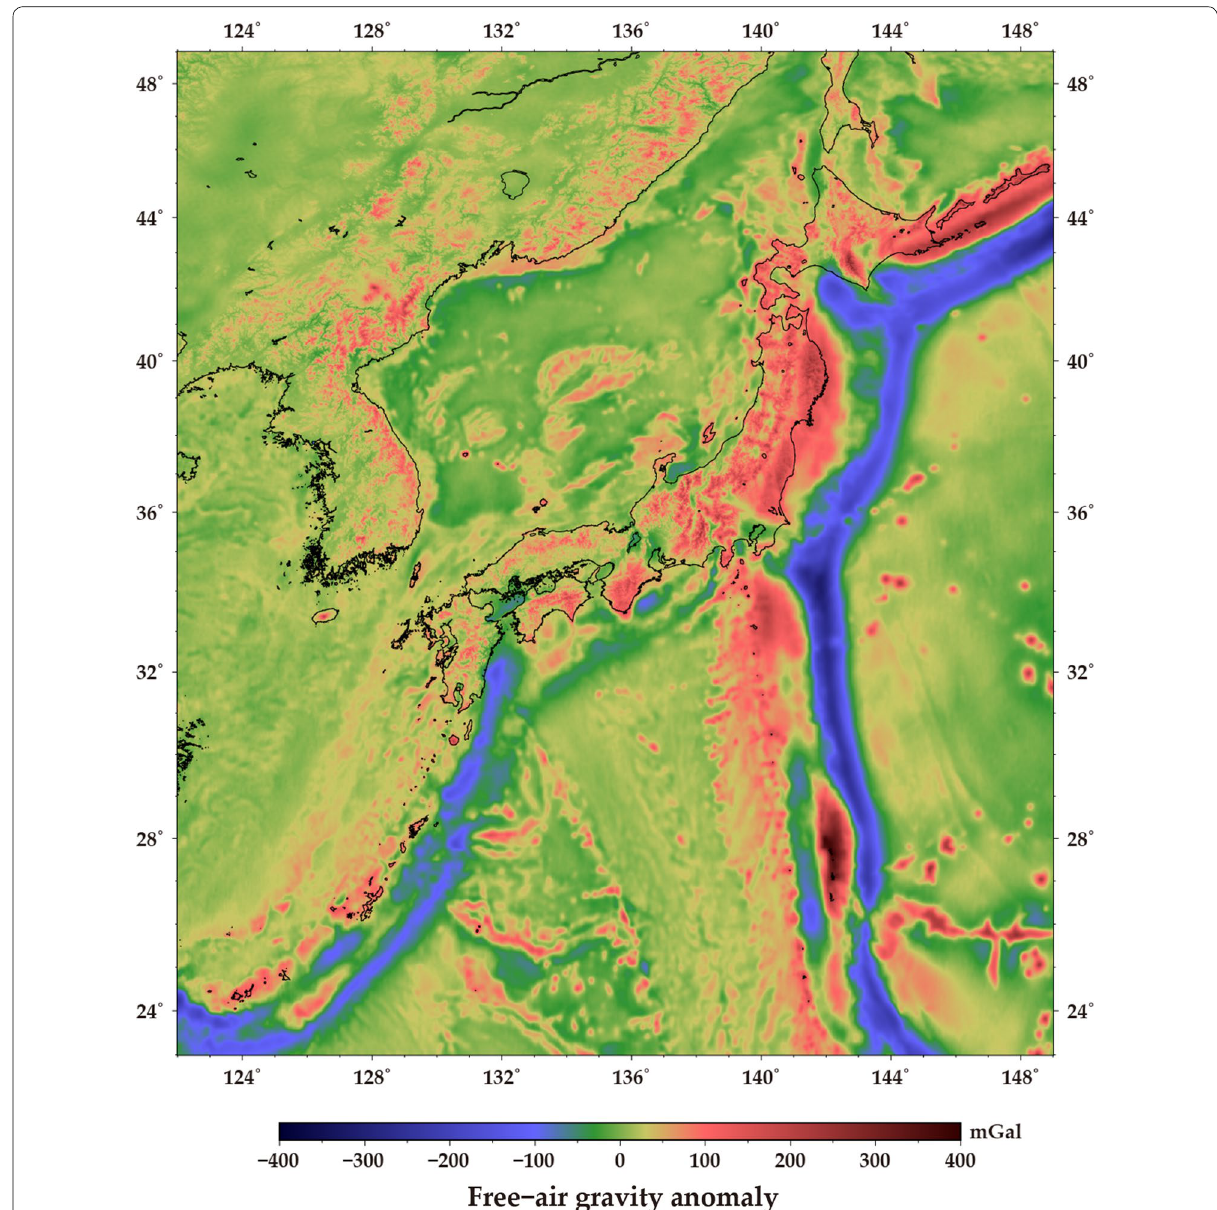
Fig. 3 Geographical map of the free-air gravity anomalies in and around Japan. The total tide effect is eliminated (tide-free